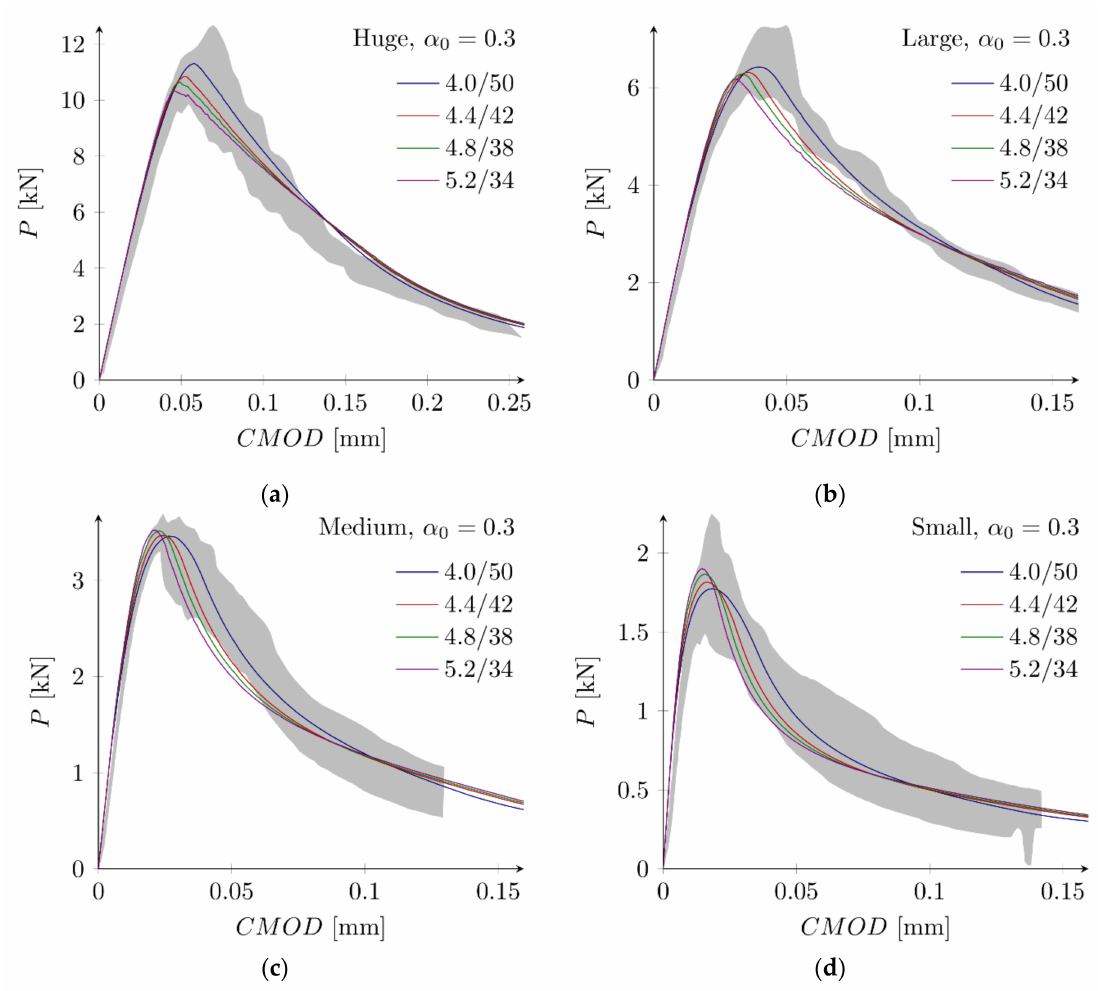
Figure 11. Force–displacement curves for notched ( α 0 = 0.3) beams and sets N1–N4: ( a ) huge beam; ( b ) large beam; ( c ) medium beam; ( d ) small beam (the first number in a label is the tensile strength in MPa, the second number is the initial fracture energy in